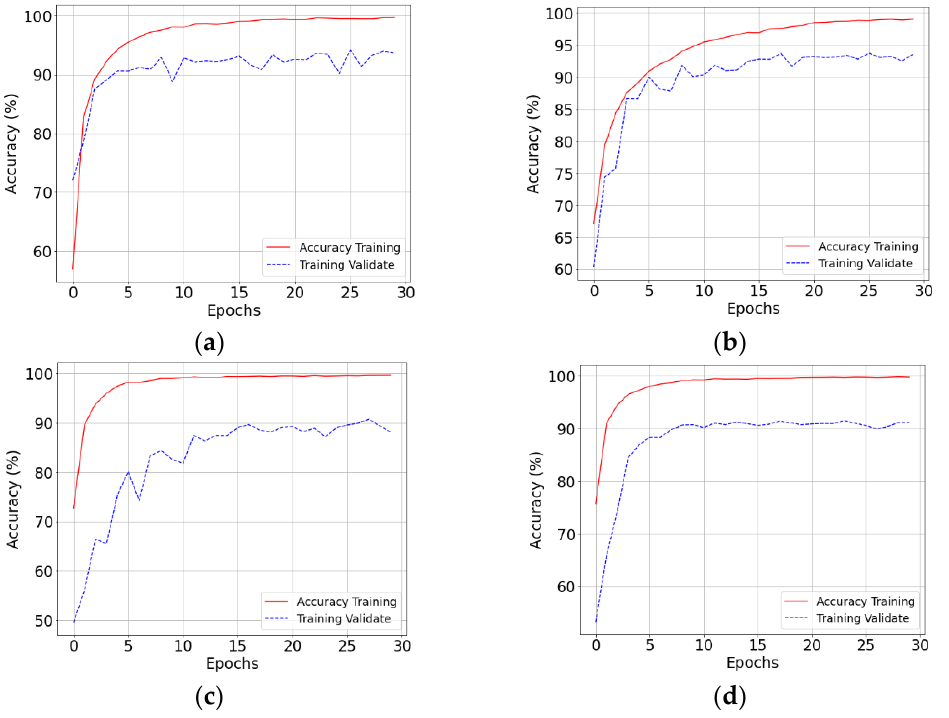
Figure 14. Training results for accuracy of the four best-performing models: ( a ) MobileNet, ( b ) SqueezeNet, ( c ) NasNetMobile, and ( d ) MobileNetV2.